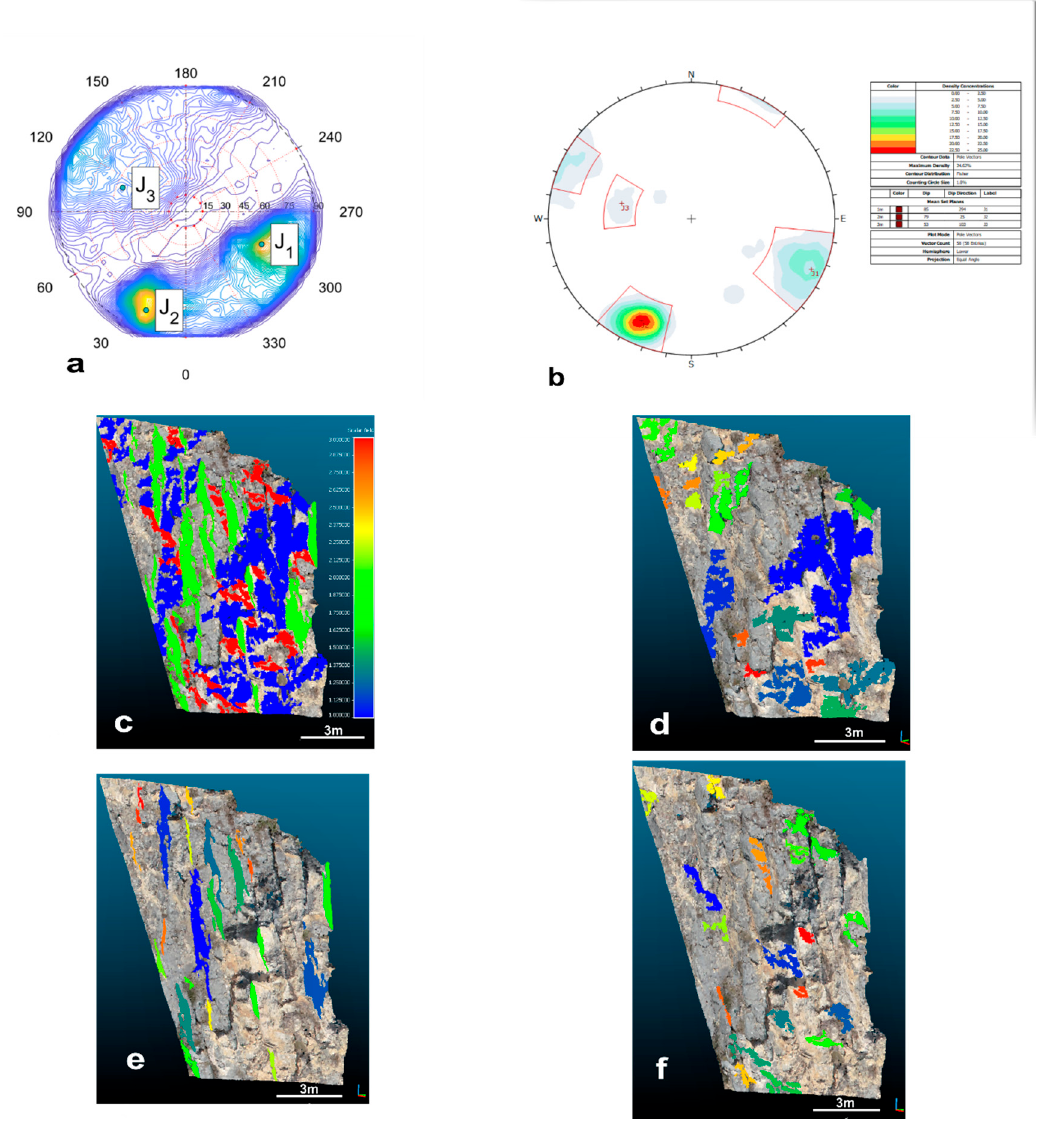
Figure 7. ( a ) Stereonet of the density of the normal vector’s poles and its corresponding planes based on DSE, ( b ) Stereographic projection of concentration lines of discontinuity poles from CloudCompare™ approach, ( c ) discontinuity sets at site 2, colored as blue ( 𝐽 1 ), green ( 𝐽 2 ), and red ( 𝐽 3 ), and ( d ) 𝐽 1 DS, ( e ) 𝐽 2 DS, ( f ) 𝐽 3 DS.